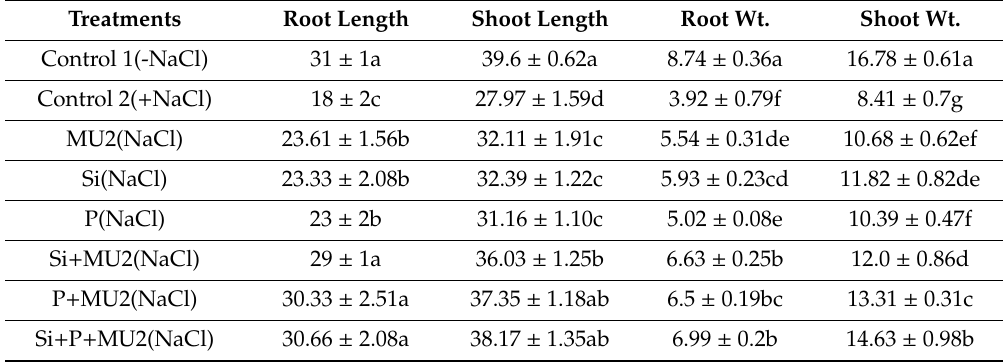
Each value represents the mean ± SD. Each data point represents the mean of at least six replicates. Di ff erent letters in the column after mean values represent the least significant di ff erences at p ≤ 0.05.